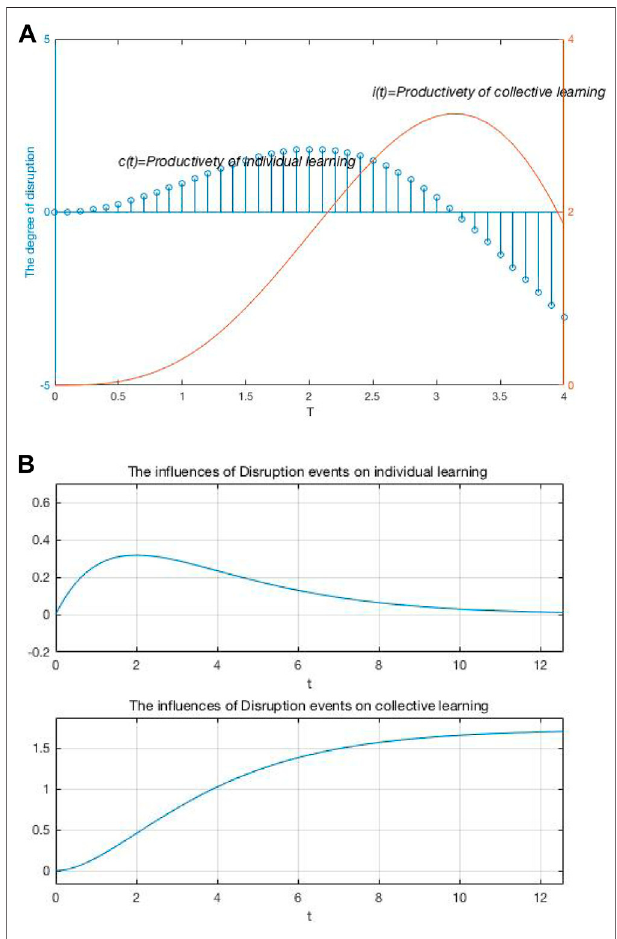
FIGURE 3 | In fl uence of disruption on individual and collective